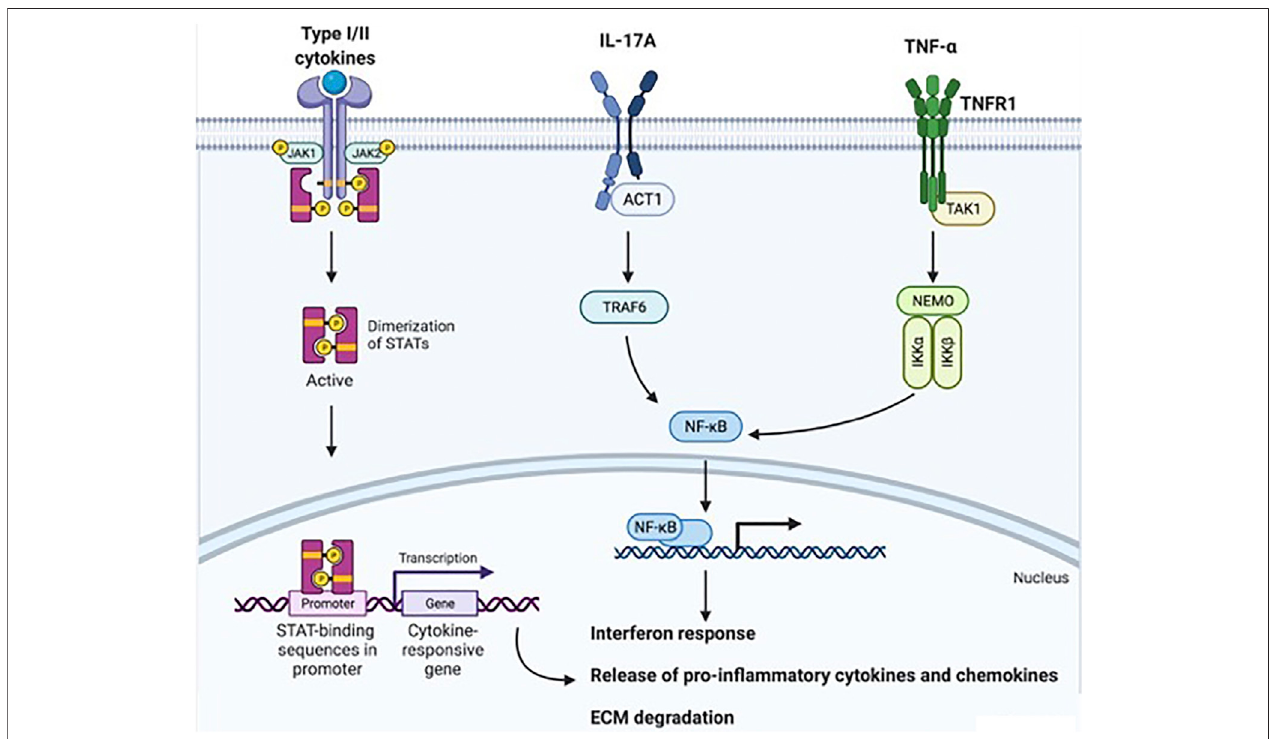
FIGURE 2 | Downstream signal transduction mechanisms following TNF- α , IL-17A, or JAK/STAT-coupled receptor activation. Type I and II cytokines (e.g., IL-23, IL-22, IL-6, and type I, II, and III IFNs) bind JAK/STAT-associated receptors. JAK proteins are associated with the cytoplasmic domain of these receptors, and when cytokines bind to the receptor, JAKs undergo autophosphorylation and phosphorylate other JAKs. STATs recognize JAKs, bind their cognate receptors and become phosphorylated by JAKs. STATs then translocate to the nucleus, bind DNA and activate the transcription of target genes for the interferon response, proin fl ammatory mediator production, and ECM degradation. IL-17A binds IL-17R, a transmembrane heterodimer of IL17RA and IL-17RC. This binding induces Act-1 activation, which in turn activates TRAF6 and, accordingly, NF-kB. NF-kB migrates to the nucleus and induces target gene transcription. TNF- α , either in its soluble or transmembrane form, binds TNFR1 or TNFR2. After binding, in the classical proin fl ammatory axis induced by TNF- α -dependent cellular activation, TAK1 engages NEMO. NEMO activation results in the phosphorylation of speci fi c serine residues in inhibitory proteins of NF- κ B (I κ Bs) by IKK-1 and IKK-2, leading to I κ B polyubiquitination and proteasome-dependent degradation. This process releases NF- κ B proteins, which translocate to the nucleus and induce target gene transcription. Taken together, these mechanisms result in an interferon response, proin fl ammatory chemokine and cytokine release, and extracellular matrix degradation. Abbreviations: TNF- α , tumor necrosis factor-alpha; IL, interleukin; JAK/STAT, Janus Kinase/signal transducer and activator of transcription; ECM, extracellular matrix; IL-17R, IL-17 Receptor; Act1, NF-kappa-B activator 1; TRAF6, TNFR-associated factor 6; NF-kB, nuclear factor kappa-light-chain-enhancer of activated B cells; TNFR, tumor necrosis factor-alpha receptor; TAK1, transforming growth factor-alpha-activated kinase 1; NEMO, NF- κ B essential modulator; IKK, inhibitor of I κ B kinase; I κ Bs, inhibitory proteins of NF- κ B. This image was created with © BioRender 2021.